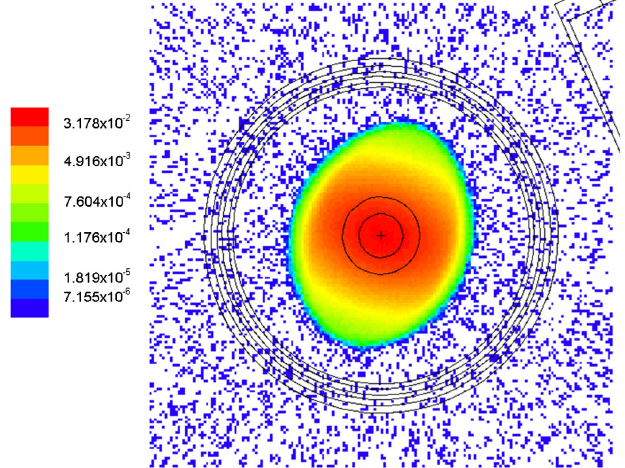
FIG. 7. Beam profile for the MEGAPIE target calculated with MCNPX based on the TURTLE output file.